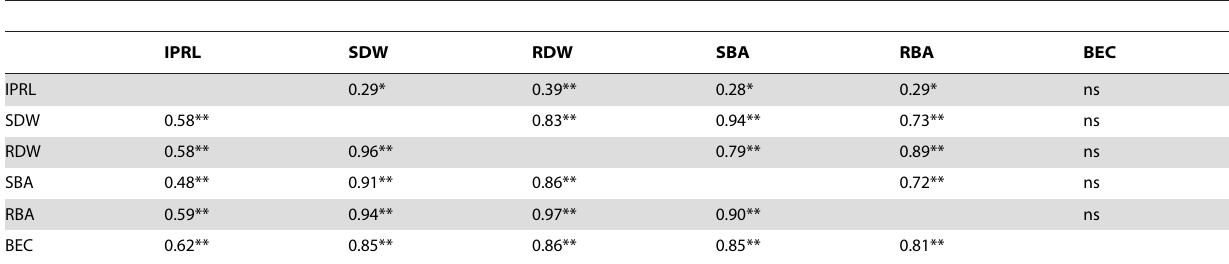
Table 3. Correlation coefficients between the tested traits under high (above diagonal) and low B (below diagonal) in the QW DH population derived from a cross between Qingyou 10 and Westar